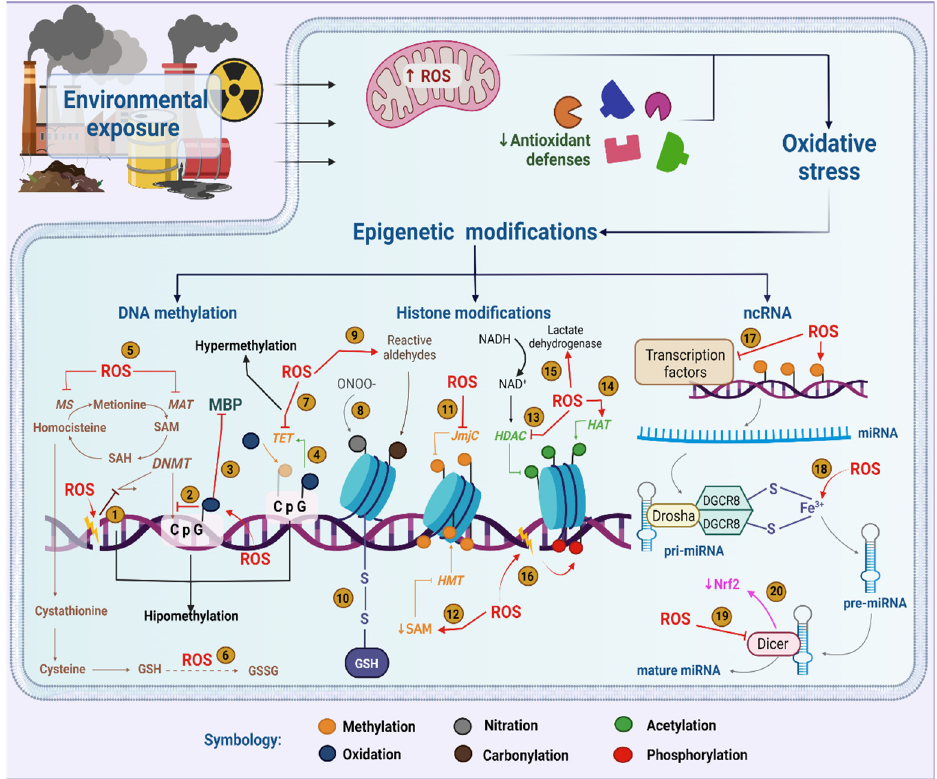
Figure 1. Role of oxidative stress in epigenetic modifications induced by environmental pollutants. ROS potentially interfere with the activity of DNMTs (1), their ability to methylate cytokines (2) or their union with the MBP complex (3). Guanine oxidation makes the methylated cytokine more susceptible to oxidation by TET enzymes (4). In addition, ROS deplete SAM by oxidizing MAT